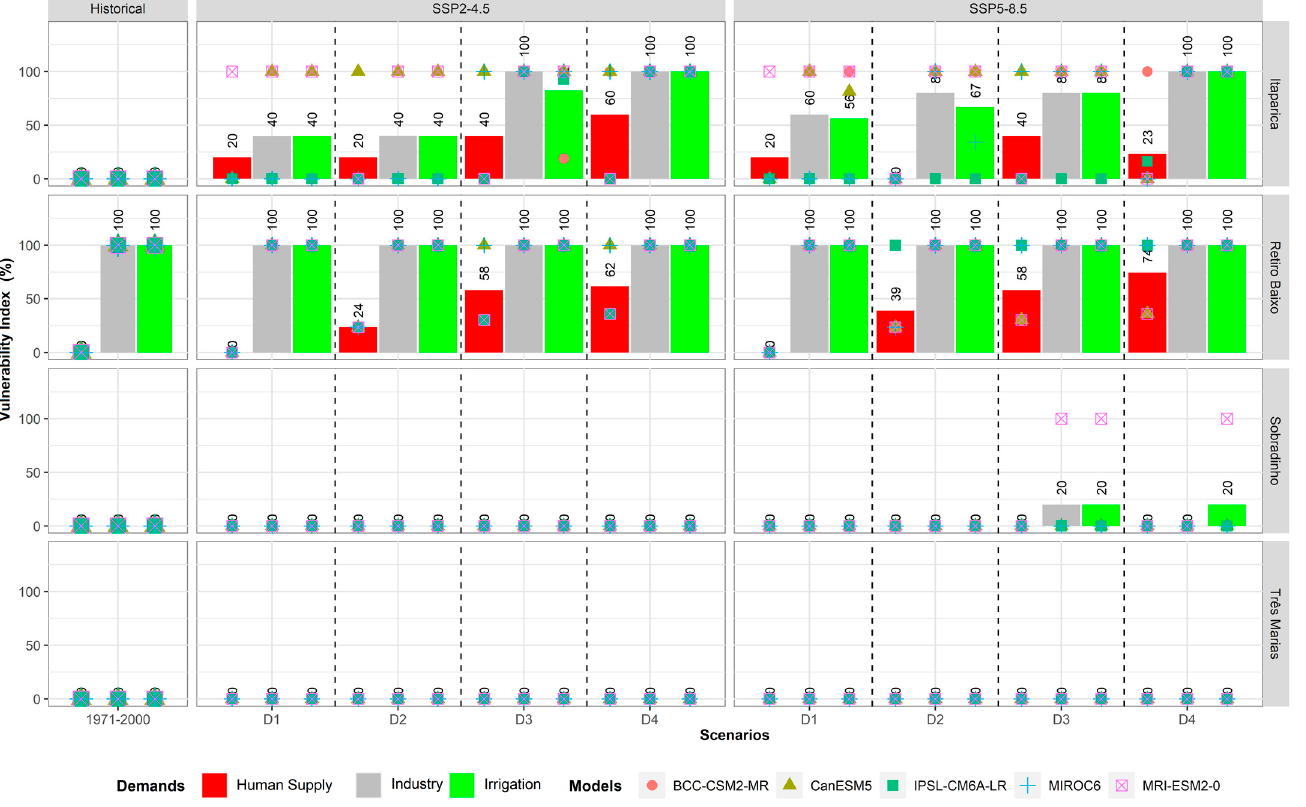
Figure 11. Vulnerability Index of CMIP6 models for historical period (1971 to 2000), climate change scenarios (SSP2-4.5 and SSP5-8.5) and consumptive demand projection scenarios (D1, D2, D3 and D4) for SFRB reservoirs. The bars are the averages of the set of models.